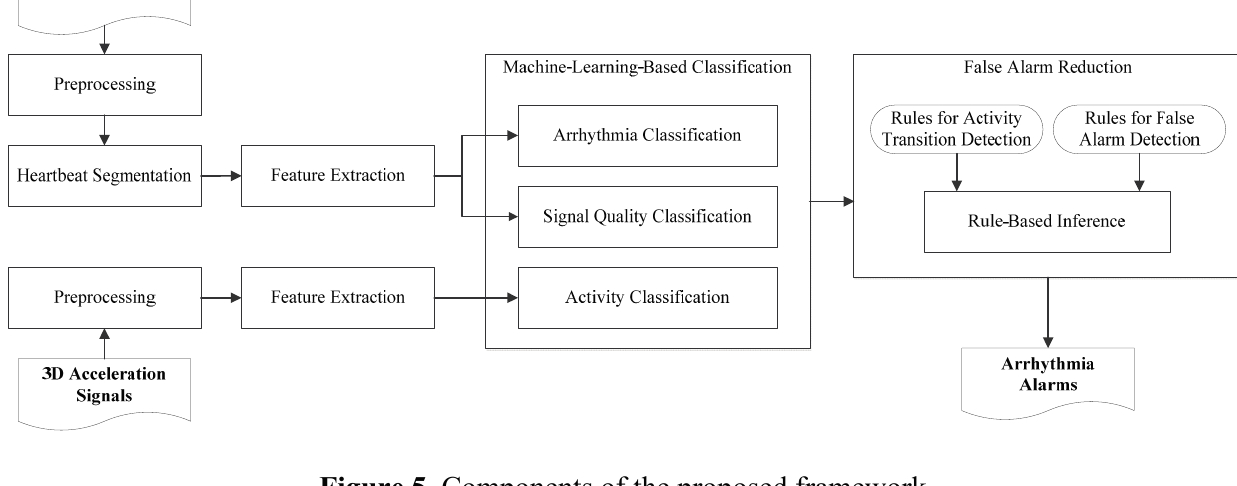
Figure 5. Components of the proposed